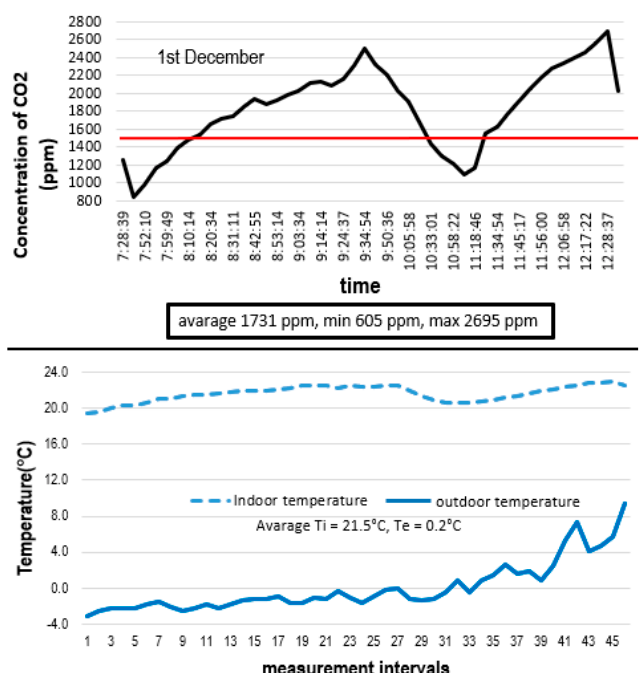
Figure 9. Daily profiles of CO 2 concentration and indoor/outdoor temperatures (1st December).